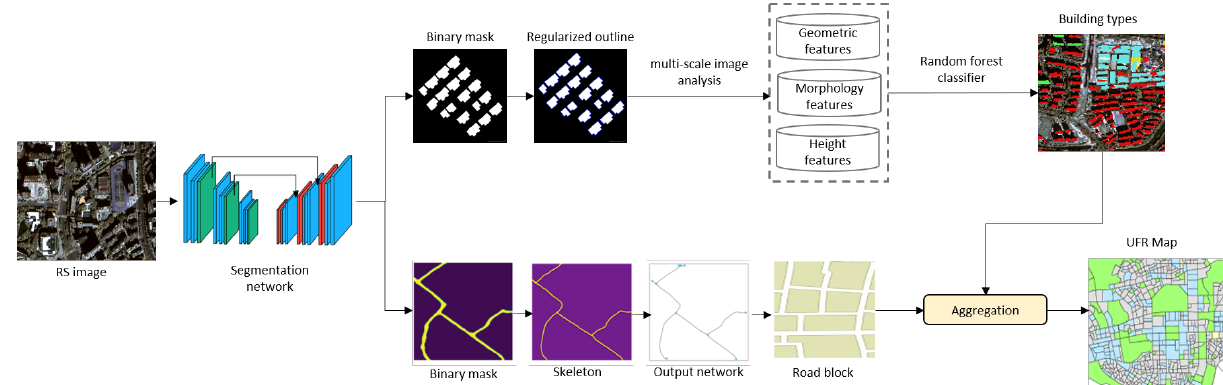
Figure 3. Overview of the proposed workflow. It inputs a remote sensing image to extract buildings and road networks, goes to building type classification based upon multi-scale image analysis, then ends with UFR identification according to the statistical characteristics of building types within the spatial units defined by the road network.